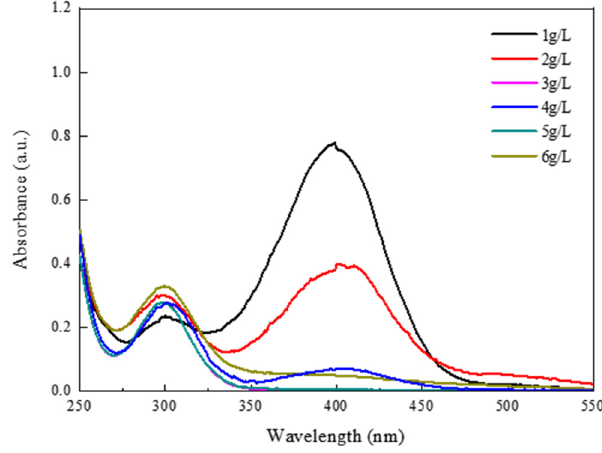
Figure 8. UV–vis absorption spectra of the 4-NP solution with various quality of 1T-MoS 2 /PC. (The initial concentration of 4-NP was 0.12 mmol/L).